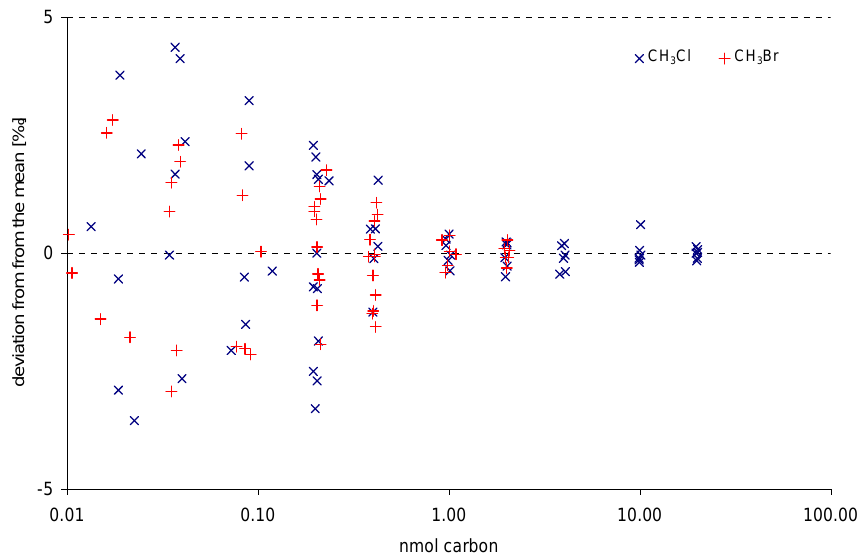
Fig. 3. Reproducibility of the δ 13 C measurements versus the carbon amount for CH 3 Cl and CH 3 Br. Results are given as deviation from the mean. The respective means were calculated from all measurements with carbon amounts from 1.0 to 20nmol. The mean δ 13 C values of the single component standards were − 32.5‰ and − 40.7‰ for CH 3 Cl and CH 3 Br, respectively.